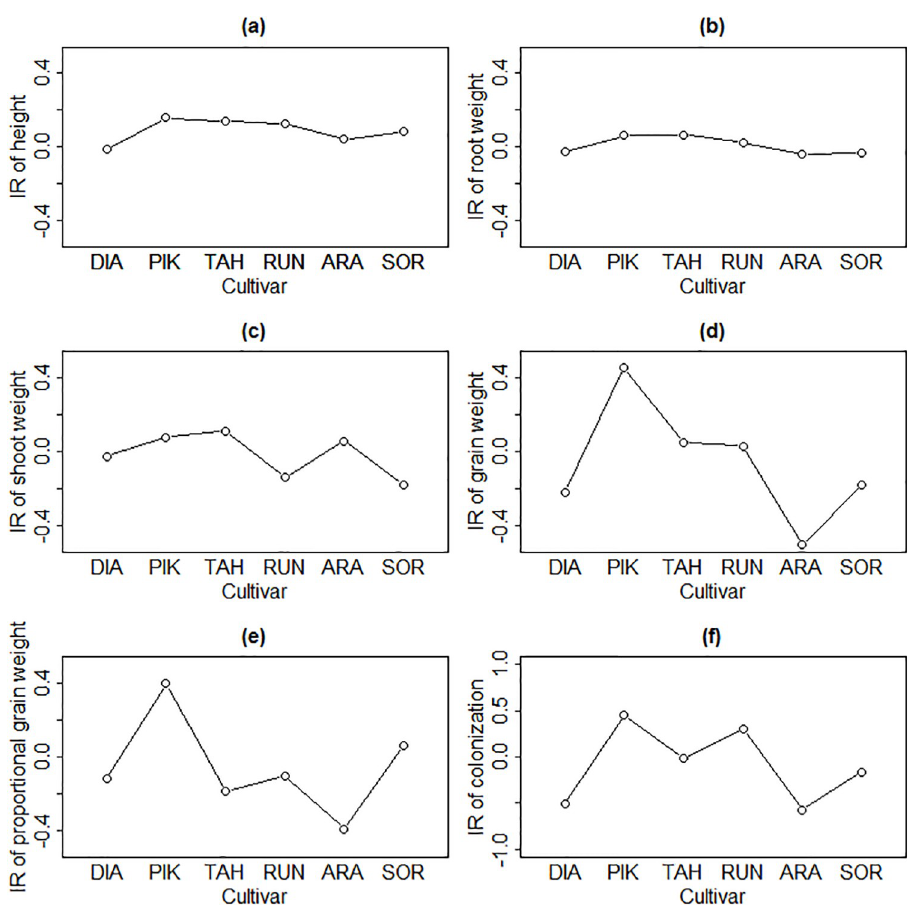
Fig 1. Average Inoculation Responsiveness (IR) of wheat cultivar traits, showing the difference of the effects of organic and conventional inocula on: (a) plant height, (b) root weight, (c) shoot weight, (d) grain weight, (e) proportional grain weight, and (f) root colonization. Higher value of IR exhibits stronger positive effect of organic inoculum. DIA: Diamant: 1929, PIK: Pikker 1959, TAH: Ta¨hti 1972, RUN: Runar 1972, ARA: Arabella 2012, SOR: Sorbas 2016. Mycorrhizal responsiveness was calculated on standardized data as: ((average plant trait value growing with organic field inoculum—average plant trait value growing with conventional field inoculum). Differences among the inoculation responsiveness of cultivars could not be statistically tested due to the fact that this proxy was based on average values (i.e. there was a lack of within-cultivar variability per plant trait). 1929 (average height ± standard deviation, 115.6 ± 6.7 cm), followed by Ta¨hti 1972 (104.0 ± 7.1 cm), Pikker 1959 (100.1 ± 9.8 cm), Runar 1972 (89.0 ± 6.3 cm), Sorbas 2016 (87.8 ± 5.7 cm) and Arabella 2012 (77.4 ± 6.1 cm). Plant height (F = 61.69, p < 0.01, Fig 3a), root weight (F = 4.83, P < 0.01, Fig 3b) and 5,104 shoot weight (F = 8.87, P < 0.01, Fig 3c) decreased from earlier to later cultivar’s year of 5,104 release. On the other hand, grain weight increased (F = 7.33, P < 0.01, Fig 3d) and propor- 5,104 tional grain weight rose (F = 14.97, P < 0.01, Fig 3e). In brief, new cultivars had shorter 5,104 and smaller shoots. The percentage of root AM fungal colonization in cultivar Diamant 1929 was higher than in Pikker 1959 (F = 11.42, P = 0.04, Fig 3f). 5,40